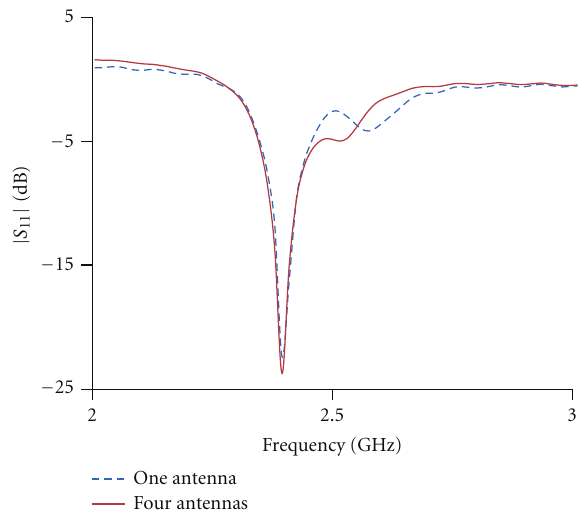
Figure 8: Experimental | S 11 | of the antenna when placed on breast phantom, when there was one antenna and four